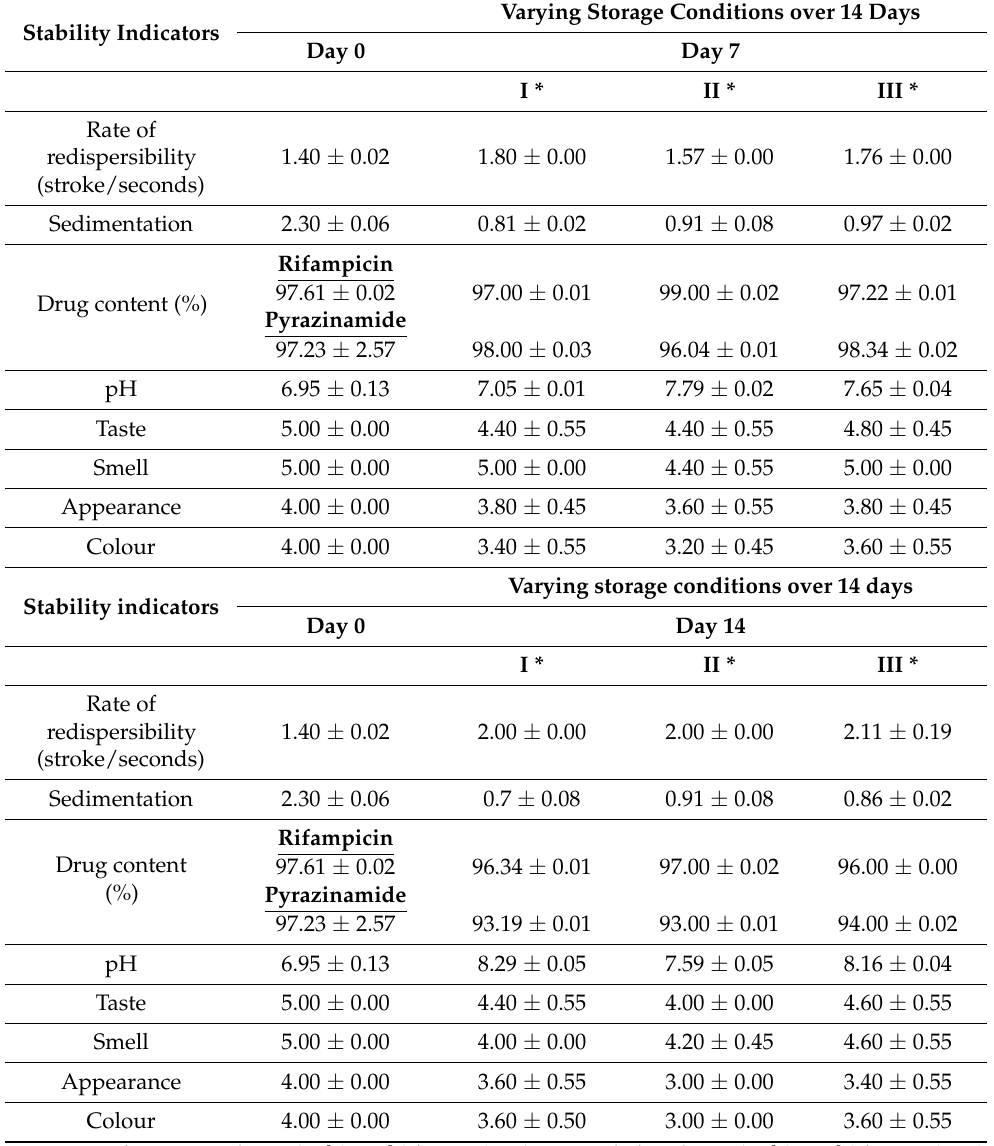
Table 9. Measured indicators of stability for the reconstituted